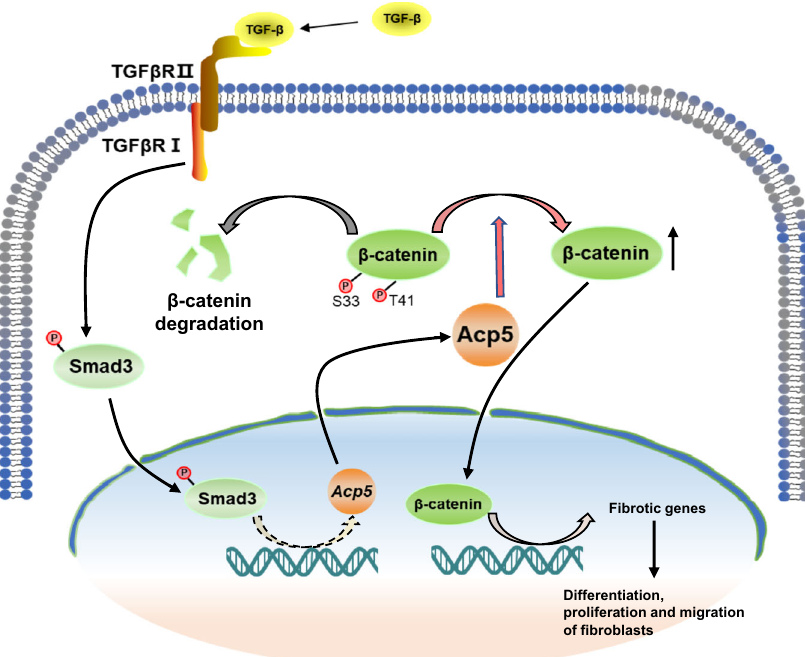
Fig. 9 Schematic illustration of the mechanisms of Acp5 in fi broblasts. Acp5 is upregulated by TGF- β 1 in a TGF β R1/Smad3 depend manner, and then Acp5 specially binds to p- β -catenin and dephosphorylate the sites of Ser33 and Thr41, by which it resists the degradation of β -catenin and enhanced β -catenin signaling in the nuclear to promote the differentiation, proliferation and migration of fi